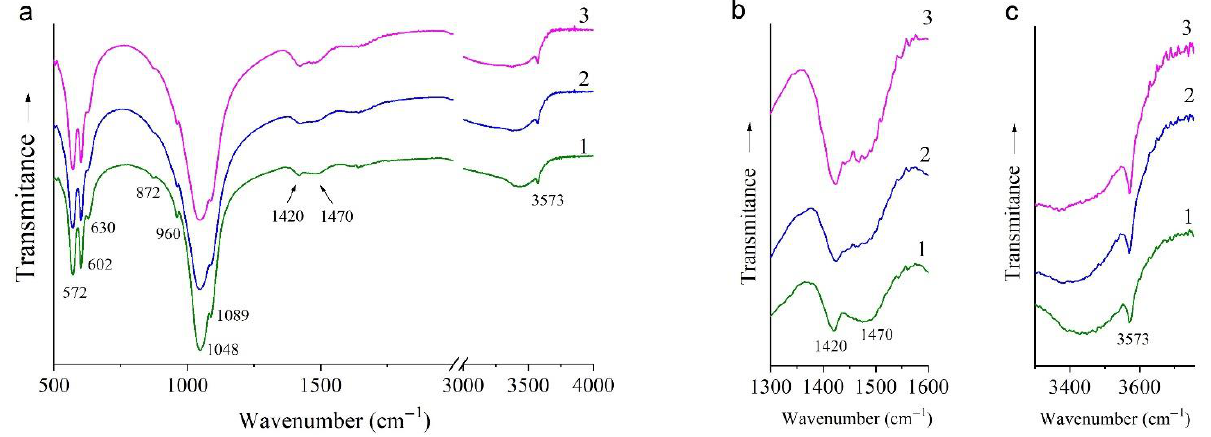
Figure 6. FTIR spectra of samples 0.0Cu ( 1 ), 0.5Cu-Ca ( 2 ), and 0.5Cu-OH ( 3 ). ( a ) General view; ( b ) enlarged view of the 1300 – 1600 cm − 1 region; ( c ) enlarged view of the 3300 – 3750 cm − 1 region.